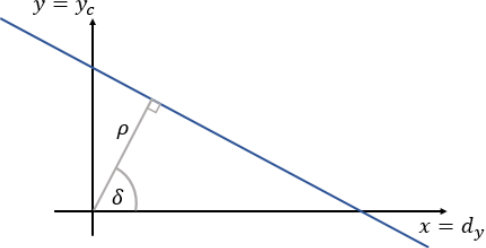
Figure 10. The normal form of the equation of a